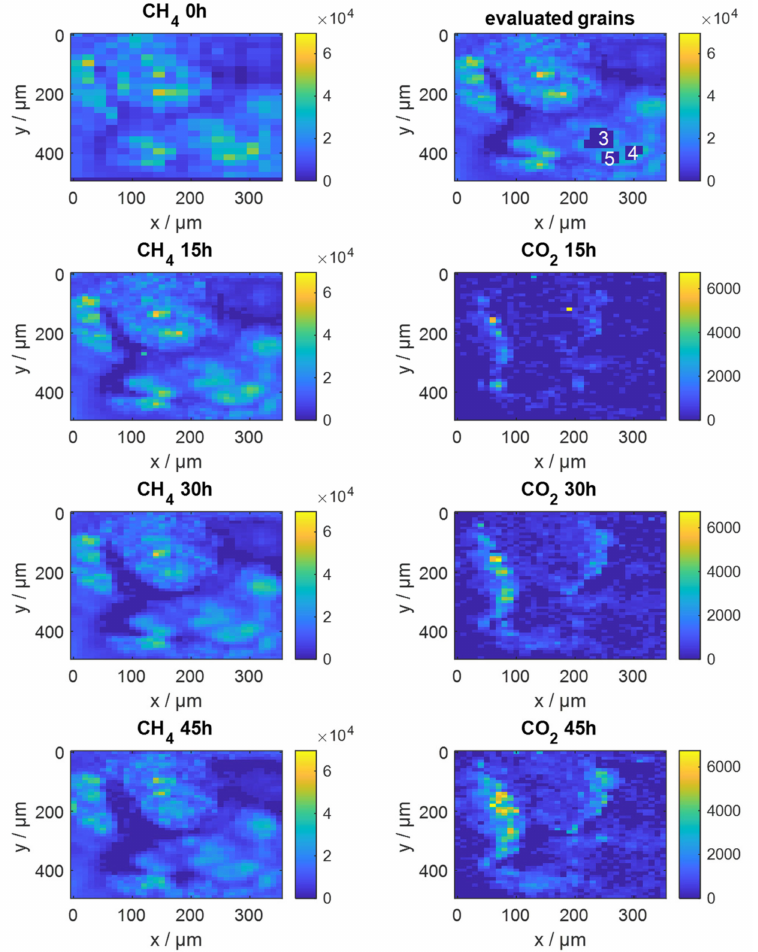
Figure 6. CH 4 and CO 2 hydrate maps of experiment NoFlowI1 at times 0 h (only CH 4 hydrate), 15 h, 30 h, and 45 h. The location of the three selected gas-hydrate grain areas for gas-exchange evaluation are marked as blue areas in the upper-right